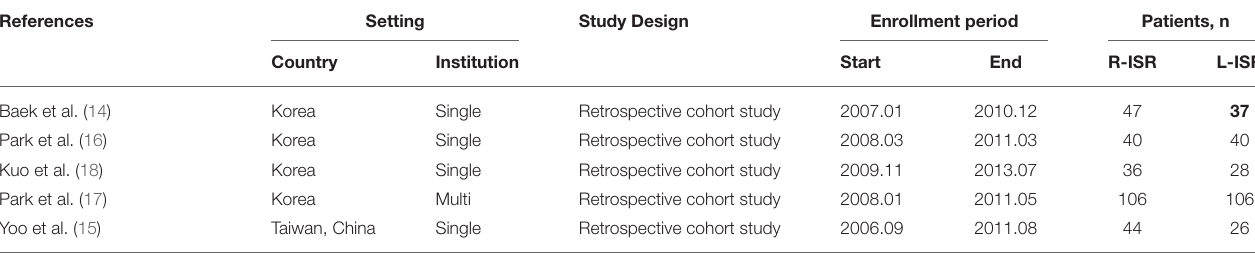
TABLE 1 | Characteristics of included